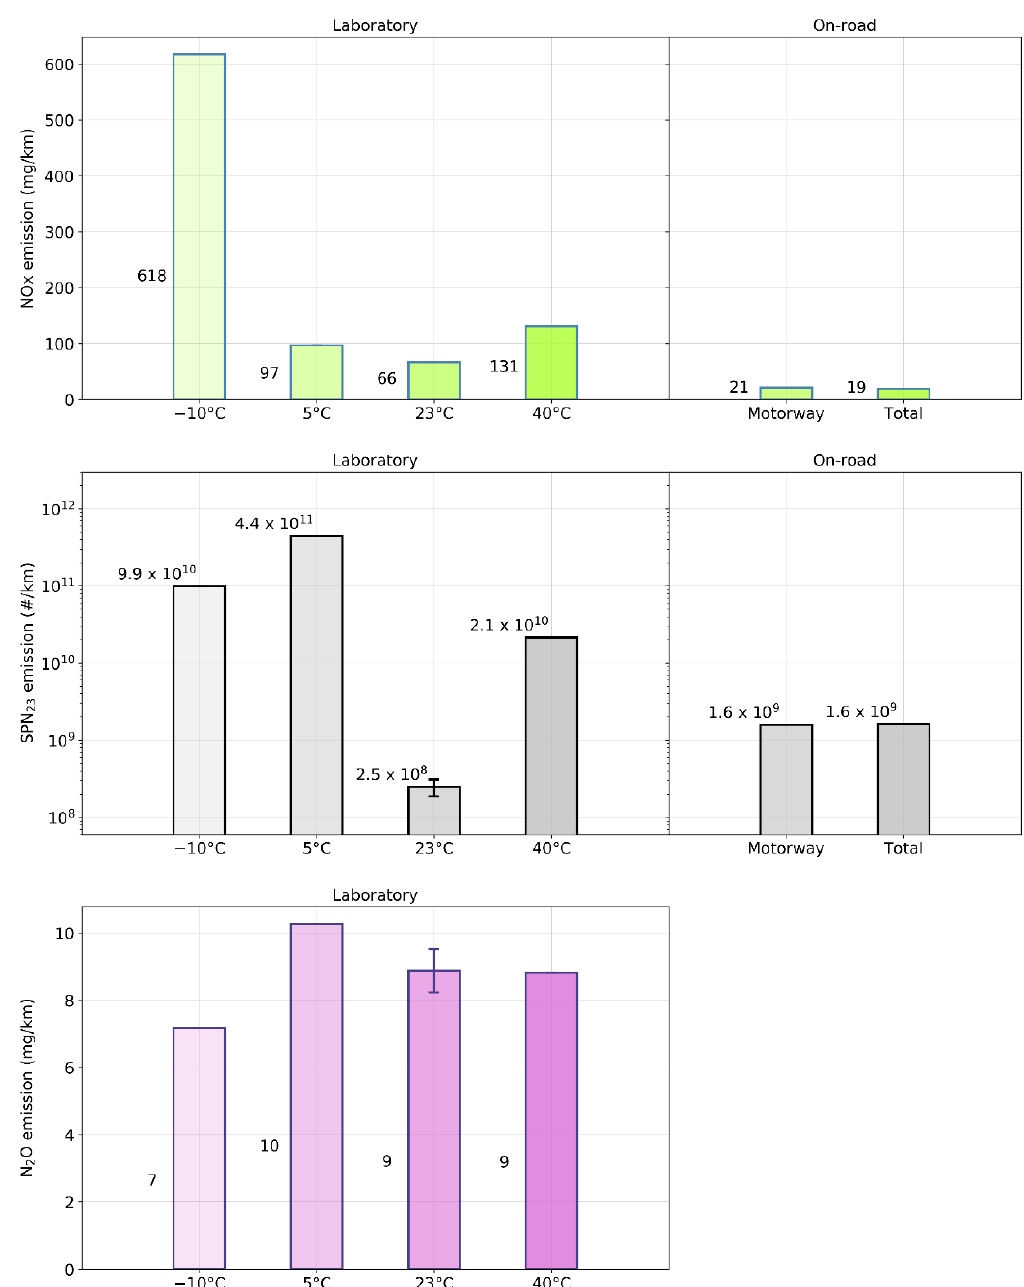
Figure 6. Emissions of regulated pollutants and N 2 O on: (left panels) BAB tests as a function of temperature; (right panels) Motorway route (when available). All the tests were performed with the minimum SOC and with the default user selectable mode of operation. Error bars on the graph represent maximum and minimum values for conditions having more than one test. See Methods section for additional details.